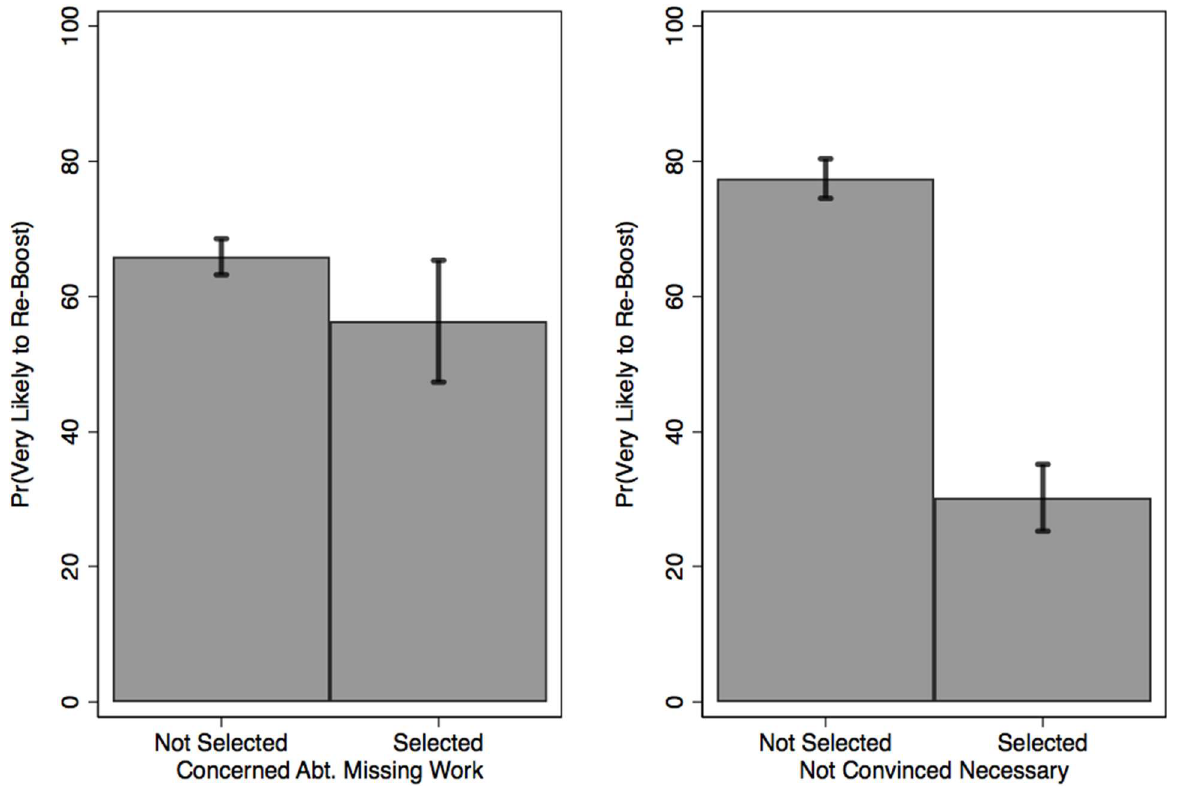
Figure 1. The Effect of Work-Related Concerns & Public Health Considerations on Vaccine Uptake. Note. Predicted probabilities (bars) are derived from logistic regression models that hold all covariates at their sample means. Predicted probabilities indicate the likelihood that respondents are “very likely” to intend to receive an additional booster vaccine are presented. Ninety-five percent confidence intervals extend out from each prediction. Analyses are limited to the sub-population who received a first (but not second) booster vaccine.